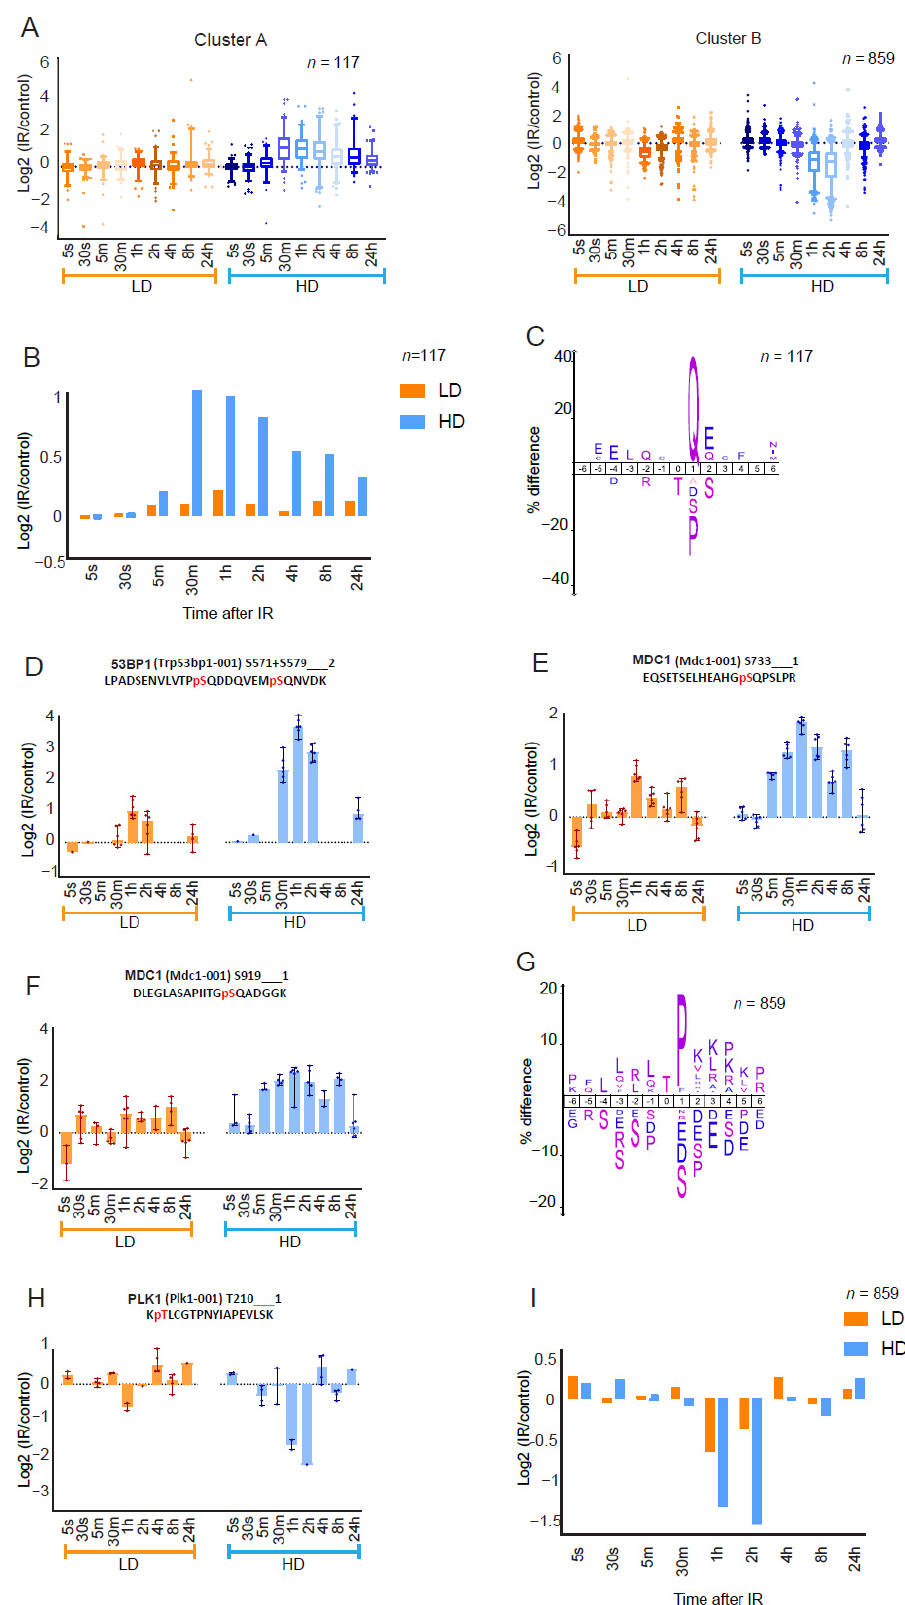
Figure 2. Dynamics of DDR signaling cascades: ( A ) Box and whisker plots of log2 SILAC ratios of averaged phosphosites of two different row clusters (hierarchical clustering) that show IR-dose de- pendent amplitude differences. Orange and blue plots indicate LD and HD data points (median value of six replicates for each phosphosite), respectively. Whiskers represent the 5–95 percentile. ( B ) Sequence motif (IceLogo) of cluster A. The phosphorylated amino acid is located at position 0. ( C ) Bar chart of relative median phosphorylation of 117 cluster A phosphosites after LD (orange) and HD (blue). ( D – F ) Dynamics of 53 BP1 (pS571 + pS579) and MDC1 (pS733 and pS919), respec- tively. ( G ) Cluster B sequence motif. ( H ) Dynamics of PLK1 T210 dephosphorylation in response to LD and HD. ( I ) Bar chart of relative median phosphorylation of 859 cluster B phosphosites after LD (orange) and HD (blue).